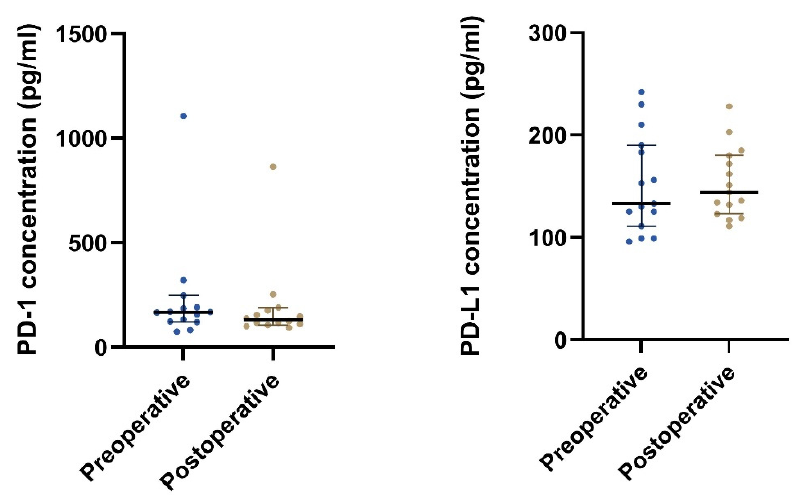
Figure 5. The plot visualizes the plasma concentrations of PD-1 and PD-L1 in the pre- (group 1A) and postoperative (group 1B) samples from patients undergoing radical surgery ( n = 15). The horizontal lines mark the median values in the two groups.